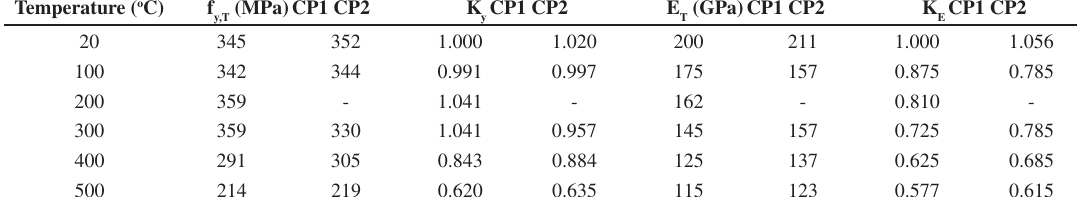
Table 2. Reduction factors according temperature.